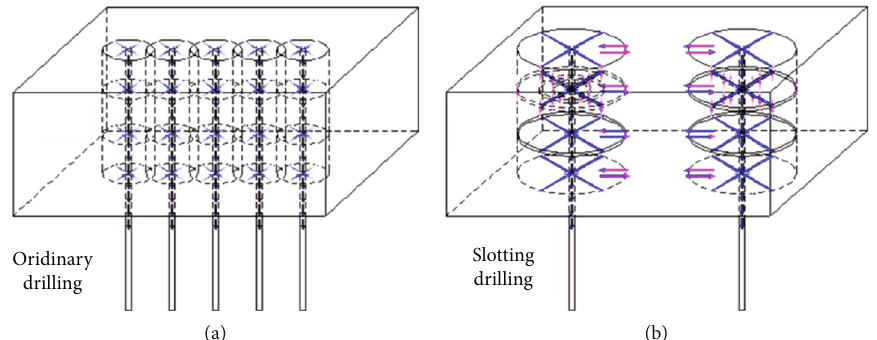
Figure 5: Gas fl ow around several boreholes. (a) Schematic diagram of extraction of common borehole group. (b) Schematic diagram of drainage of slotted drilling group.